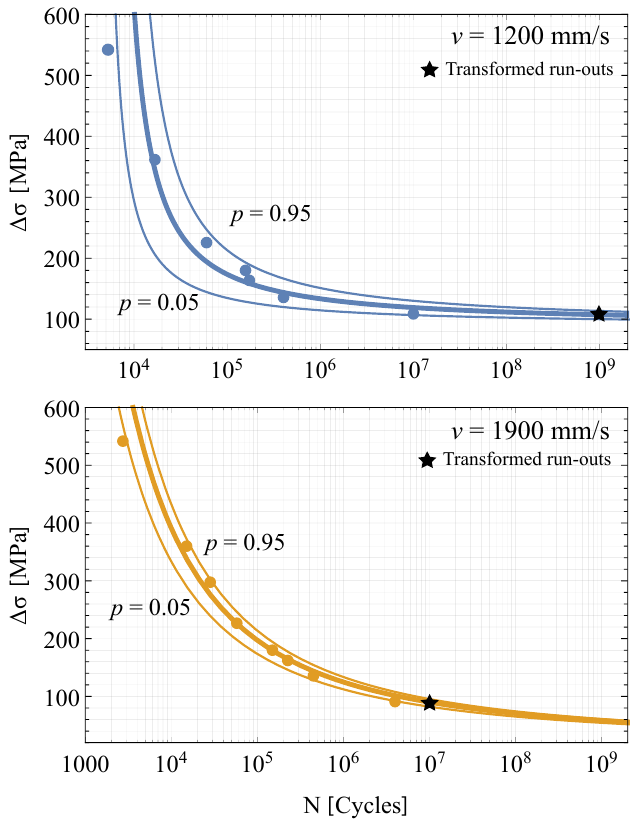
Figure 8. Resulting S–N curves from the Castillo–Canteli model for Ti-6Al-4V with velocities 1200 mm/s and 1900